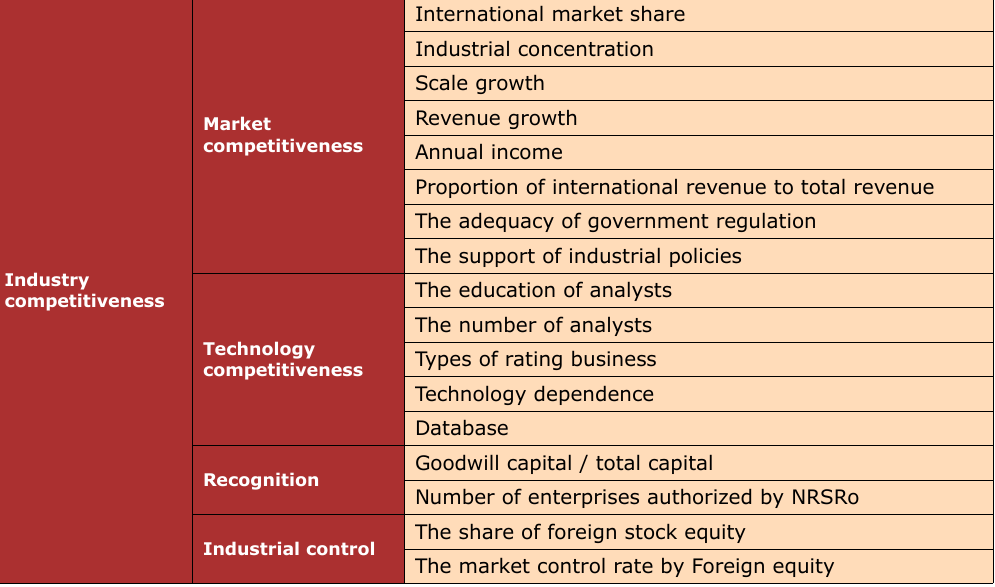
Table 2. Indicator